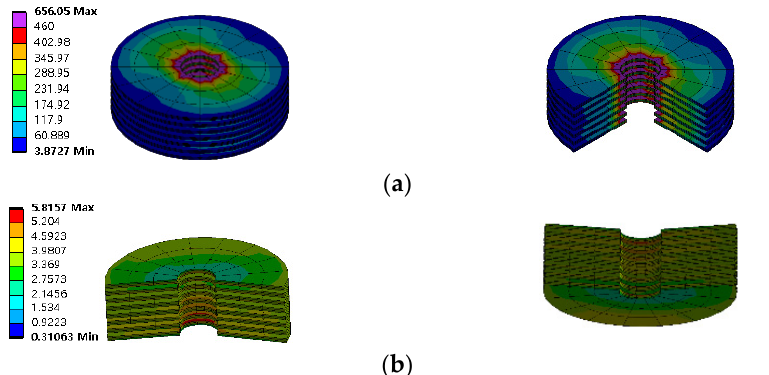
Figure 8. Analysis results of LRB simulating shaking table tests (DBE: 0.6 g): ( a ) steel layer; ( b ) rubber layer. Table 4. Analysis results of max. equivalent stress on the rubber and steel layers.